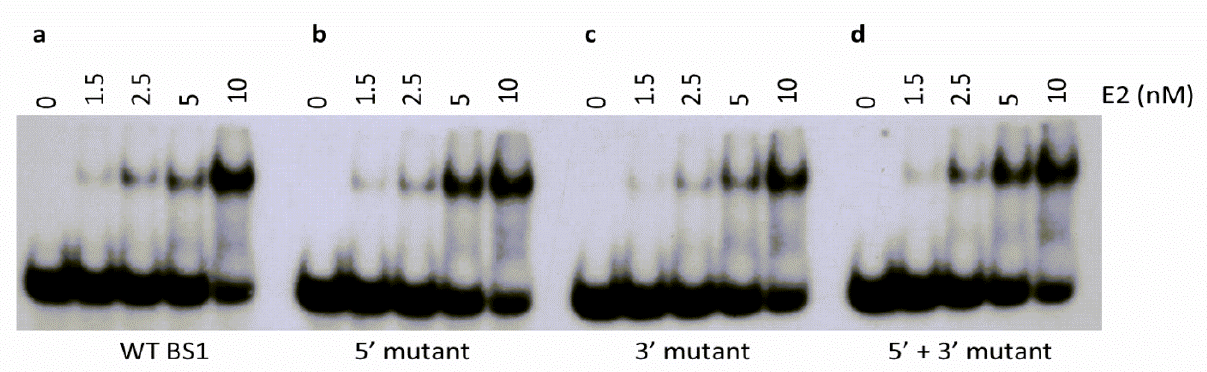
Figure 6. Effects of flanking sequences on DNA binding by E2 protein. The binding affinities of E2 for its four binding sites were determined by EMSA. ( a ) Core oligonucleotide sequence with native flanking sequences of E2 BS1 (WT BS1). All the other three oligonucleotides possessed alterations in the flanking sequences of BS1. ( b ) The BS1 5 (cid:48) flanking sequence was replaced with the BS3 5 (cid:48) flanking sequence (5 (cid:48) mutant). ( c ) BS1 3 (cid:48) flanking sequence was substituted with that of BS3 (3 (cid:48) mutant). ( d ) The double mutant (5 (cid:48) + 3 (cid:48) mutant) was replaced with both the 5 (cid:48) and 3 (cid:48) flanking sequences from BS3. The E2 protein concentrations were as indicated.